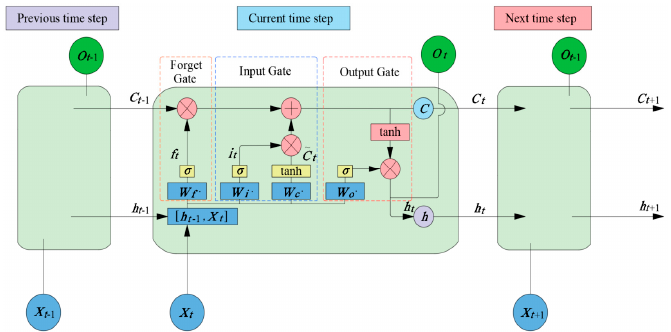
Figure 1. LSTM structure diagram.